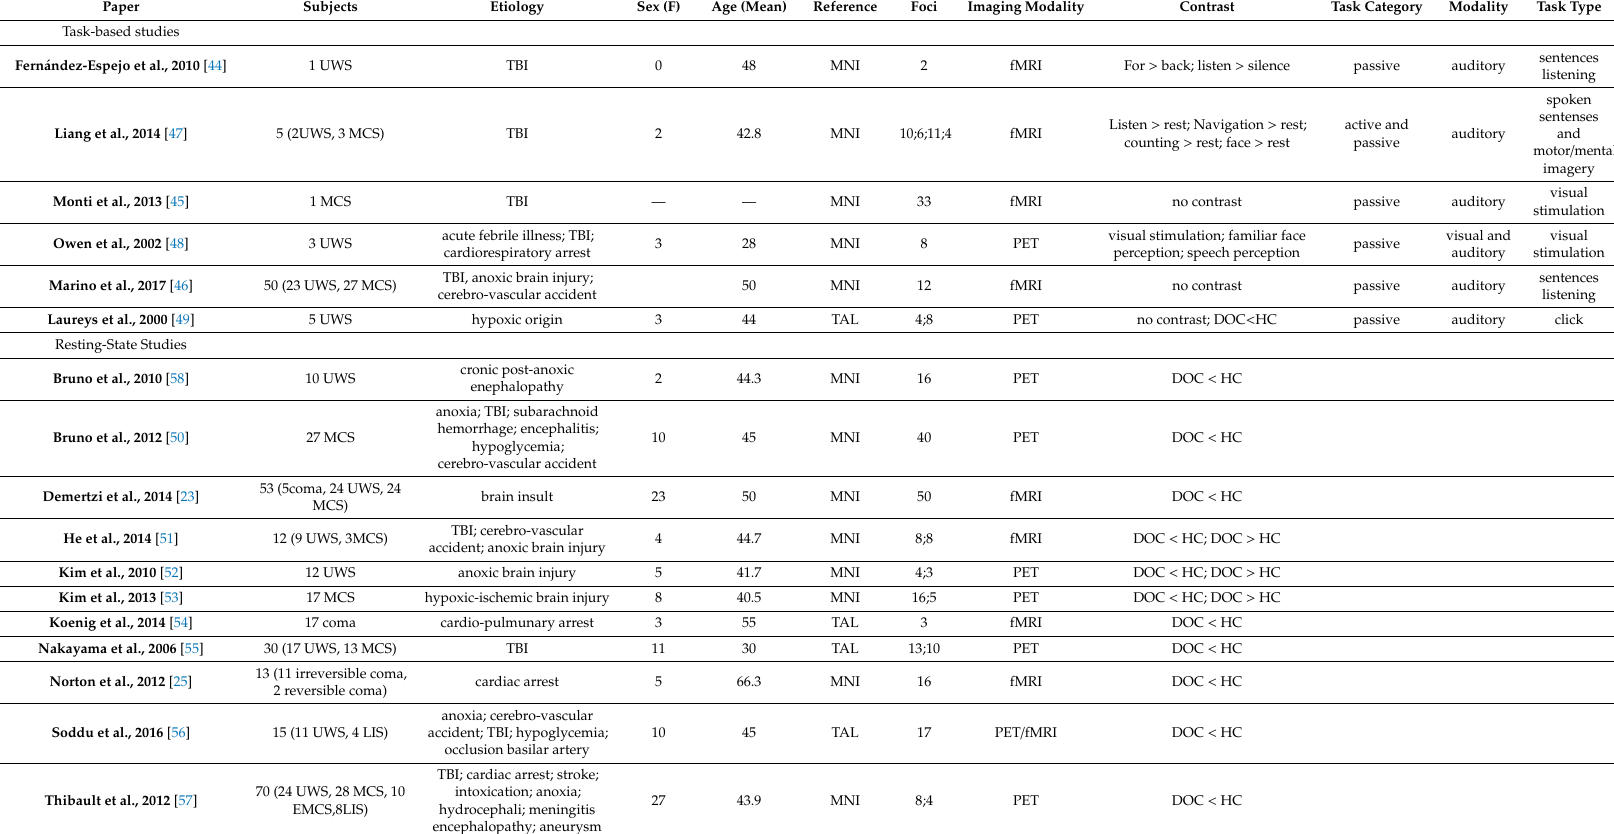
Table 1. List of studies considered in the meta-analysis. Sample size, etiology of DoC (Disorder of Consciousness), gender and age of sample, reference MRI space, number of foci, imaging modality and experimental conditions are shown. Additional information about the specific experimental paradigm are reported for task-based studies. Patients labeled as in a “coma” were relabeled as Vegetative State (VS); studies specifically comparing Locked-in Syndrome (LIS) and Emerged from Minimally Conscious State (EMCS) patients were not included in the analysis due to small sample